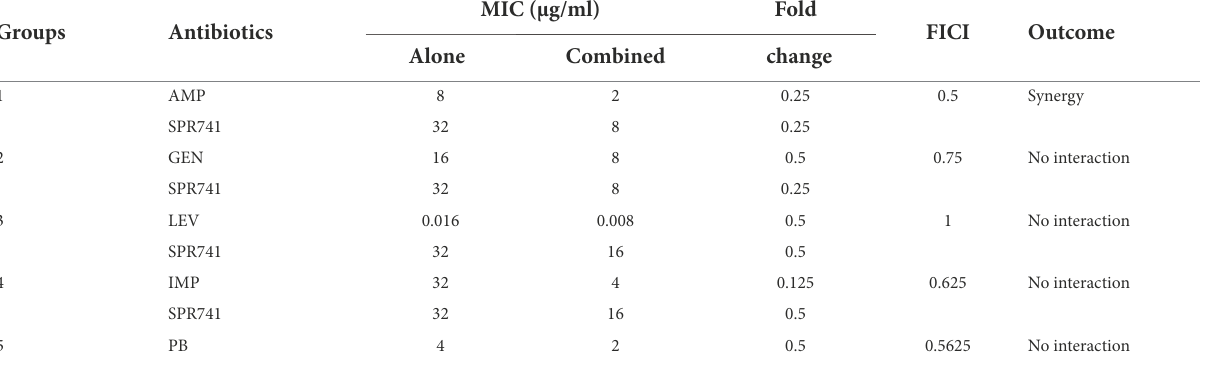
TABLE 1 Drug combinations between SPR741 and conventional